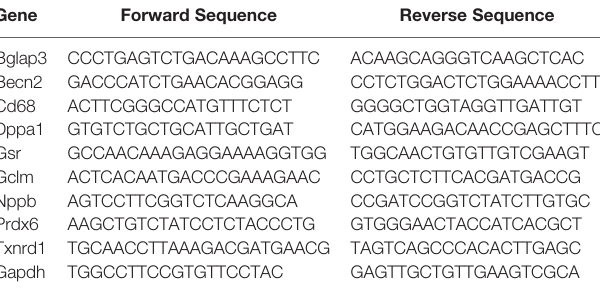
TABLE 1 | Quantitative PCR primer